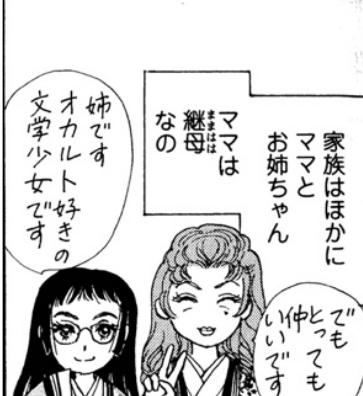
Figure 13. Heroine’s older sister and stepmother posing for a photo (Shimizu 2014, 9). Courtesy of